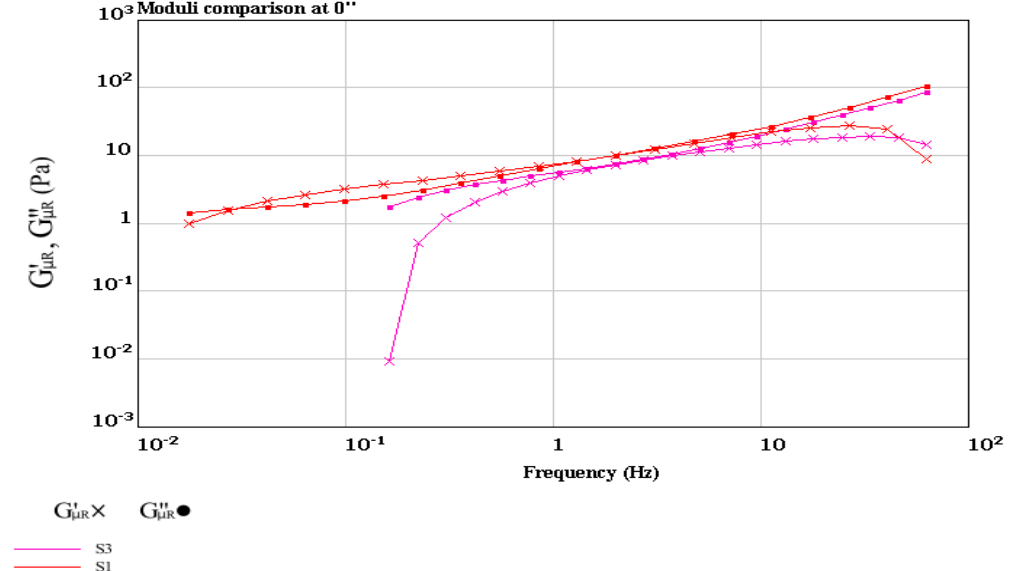
Figure 7. Storage modulus (G ′ ) and loss modulus (G ″ ) of the control plain yogurt (S1) and synbiotic yogurt with 0.5% Saccharomyces boulardii + 1 % inulin (S3).